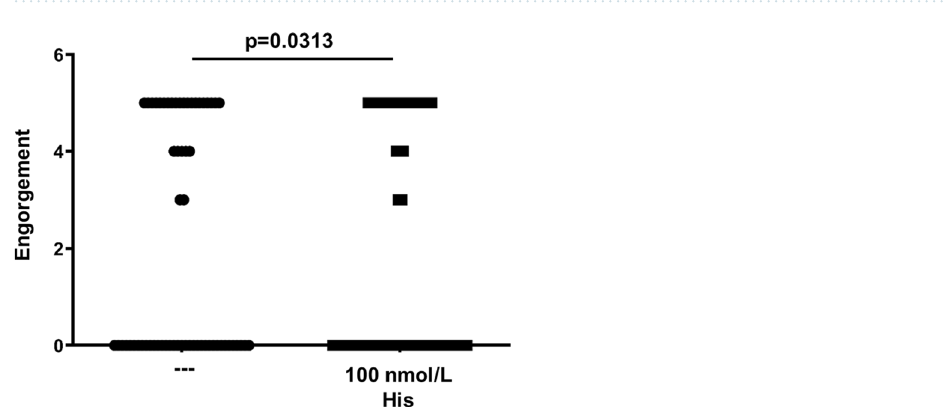
Figure 3. Influence of oral antihistamine treatment on mosquito feeding. A total of six mosquitoes were allowed to feed on the forearms of ( A – C ) hypersensitive or ( D – F ) non-sensitive human subjects without (−) and with ( +) oral antihistamine treatment. ( A , D ) The wheal diameter that developed after each mosquito bite was quantified. ( B , E ) The number of probing attempts was quantified. ( C , F ) Mosquito engorgement was quantified on a 0–5 scale. Statistical significance between groups was determined after testing for normal distribution using the Kolmogorov–Smirnov test. Student’s t tests were used for normally distributed data. Mann–Whitney tests were used for data that was not normally distributed.